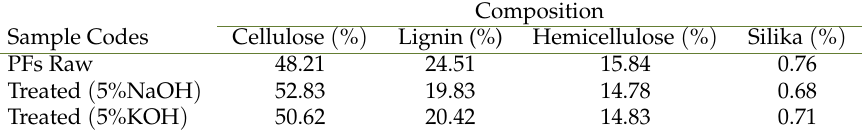
Table 3. Chemical composition of raw, PFs treated NaOH, and PFs treated KOH. Composition